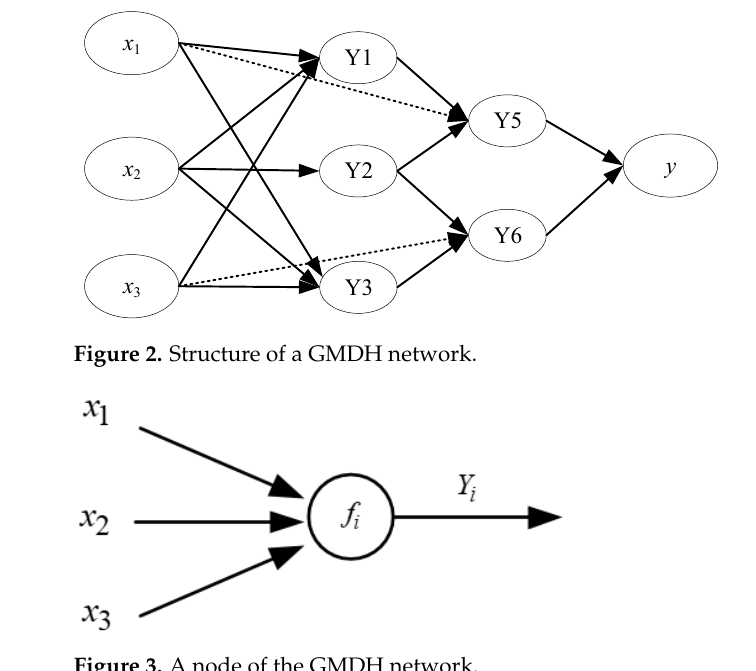
Figure 3. A node of the GMDH network.